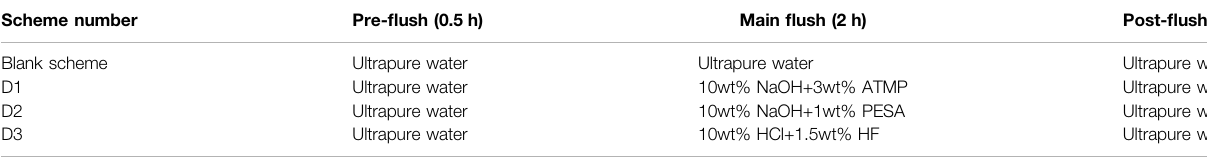
TABLE 1 | Scheme of the dynamic simulation experiment. Scheme number